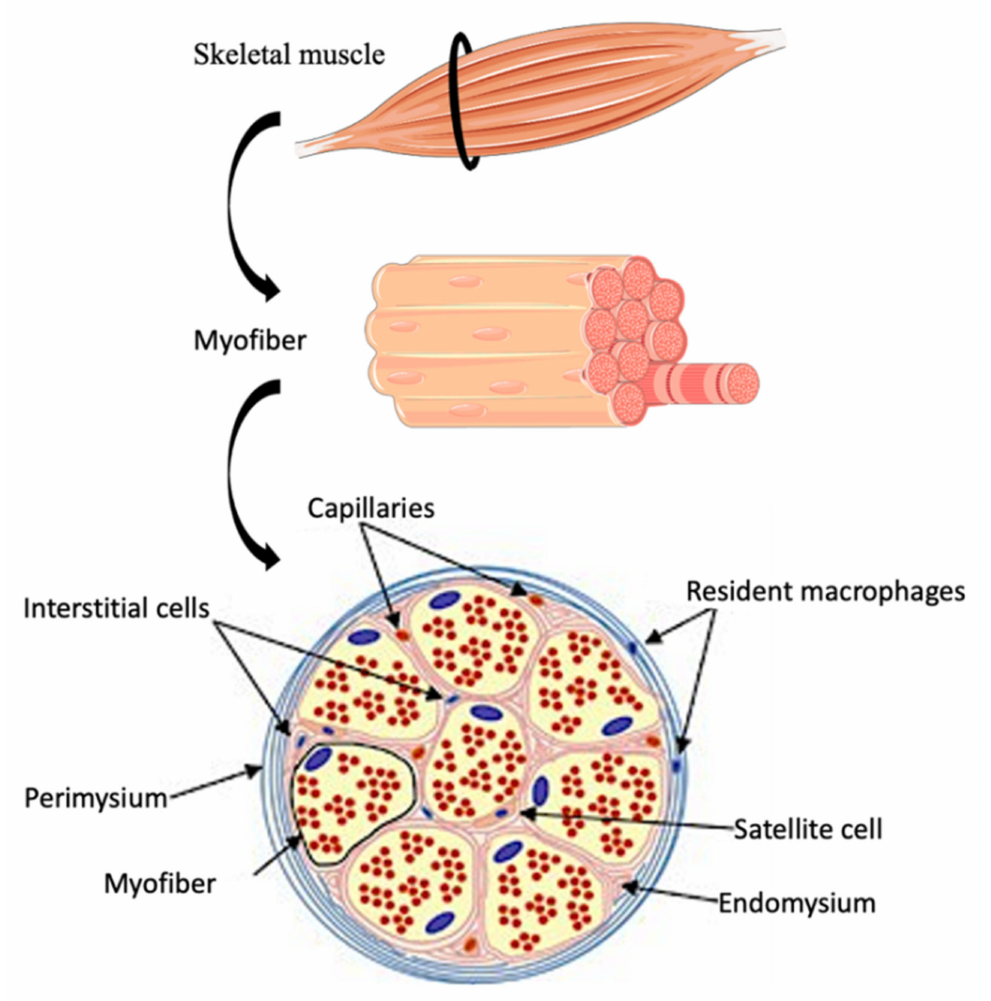
Figure 1. Schematic representation of the skeletal muscle structure. The connective tissue, called perimysium, surrounds groups of fibers, organized in multinucleated and longitudinally aligned bundles. Each single muscle cell, or myofiber, is surrounded by endomysium. Satellite cells are located between the connective tissue sheet and the myofiber plasma membrane, called